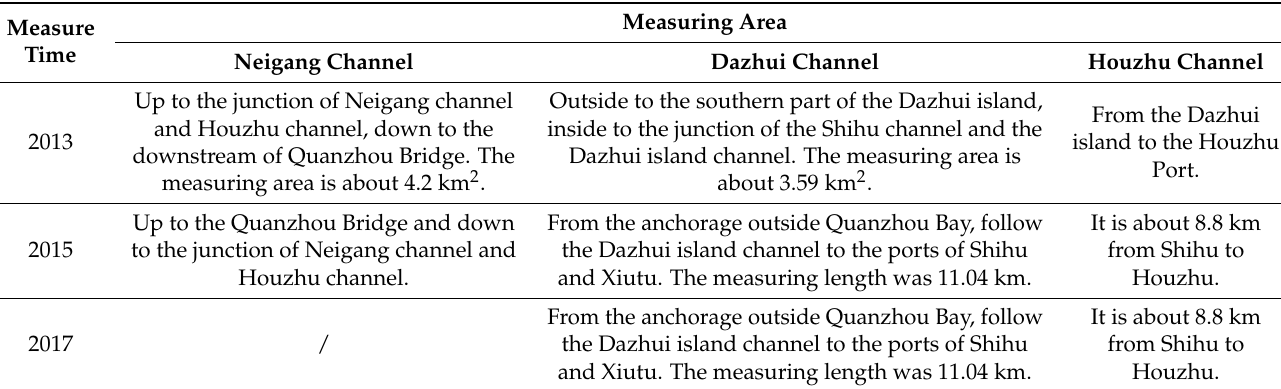
Table 2. Channel maintenance time and area